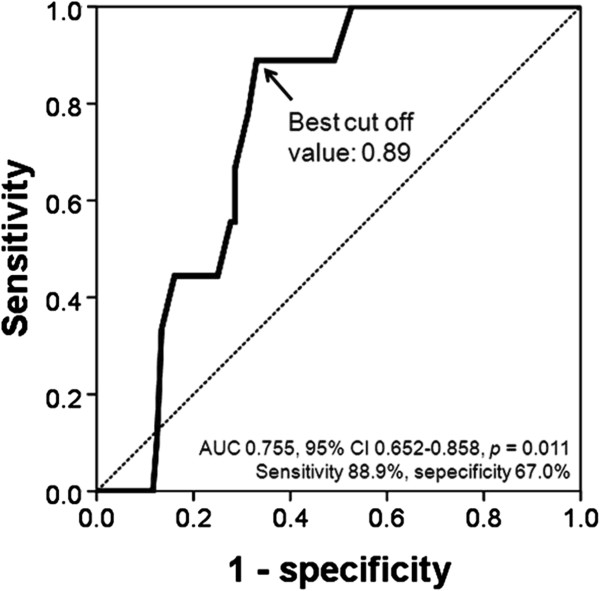
Receiver operating characteristic curve analysis showing the value of lateral e’/a’ predicting left atrial volume index ≥ 34 ml/m2. AUC, area under curve; CI, confidence interval.